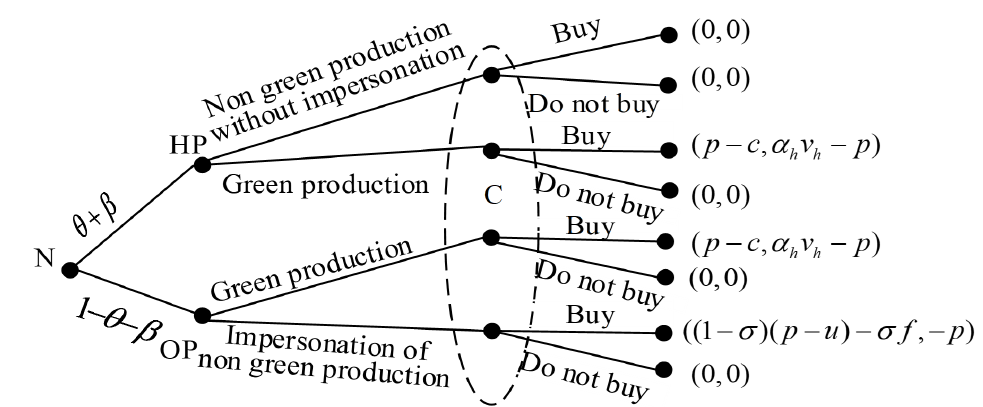
Figure 1. Game tree between farmers and consumers in each